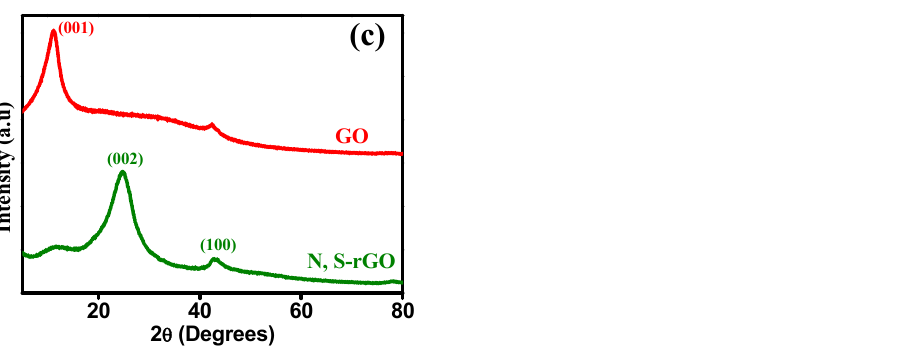
Figure 1. ( a ) XRD patterns of CeO 2 and Co-doped CeO 2 ; ( b ) CeO 2 /N, S–rGO and Co-doped CeO 2 /N, S–rGO; ( c ) GO and N, S–rGO.